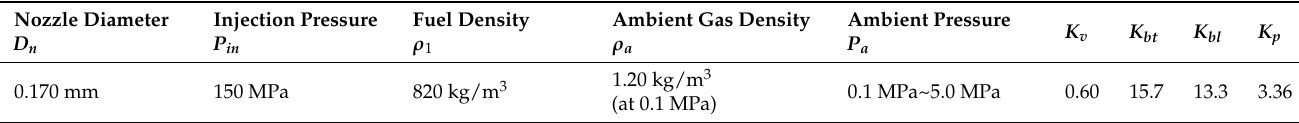
Table 3. Length and time of breakups for tested spray jets. P a (MPa)